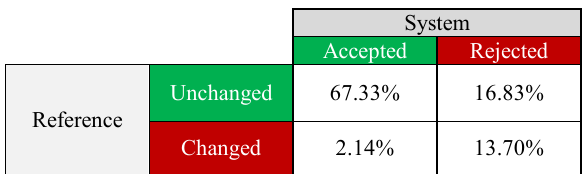
Table 4: Confusion matrix for the cropland objects.